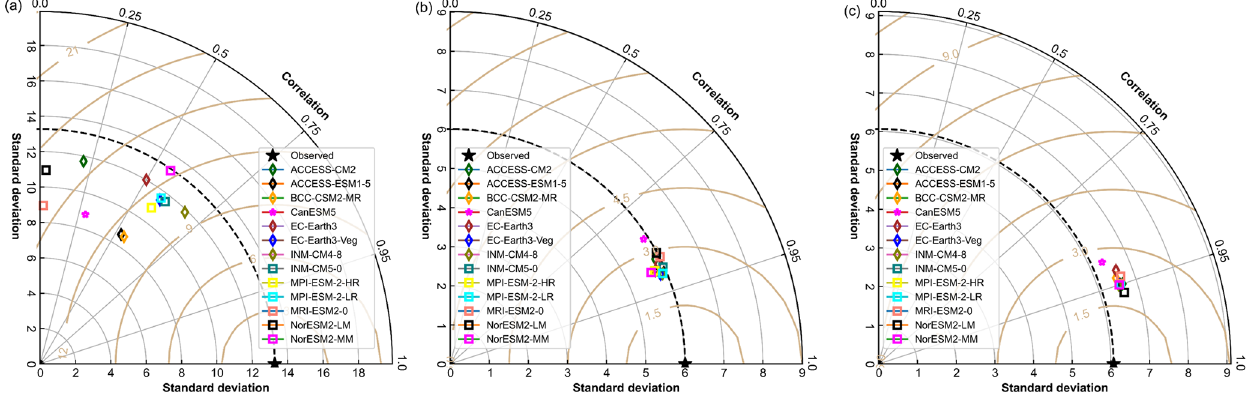
Figure 2. Taylor diagram showing comparative skills of 13CMIP6 GCMs in simulating climatic variables (rainfall, T max , and T min ) over the Sutlej sub-basin during reference period (1979–2009). The degree of the correlation coefficient ( r ) between the observed and CMIP6 GCMs, centred root mean square error (CRMSE), and departure of the models’ standard deviation (SD) from the observed data (dashed black arc line) are shown in panel (a) for rainfall, panel (b) for T max , and panel (c) for T min . The units of SD for rainfall and temperature are in centimetres and degrees Celsius,